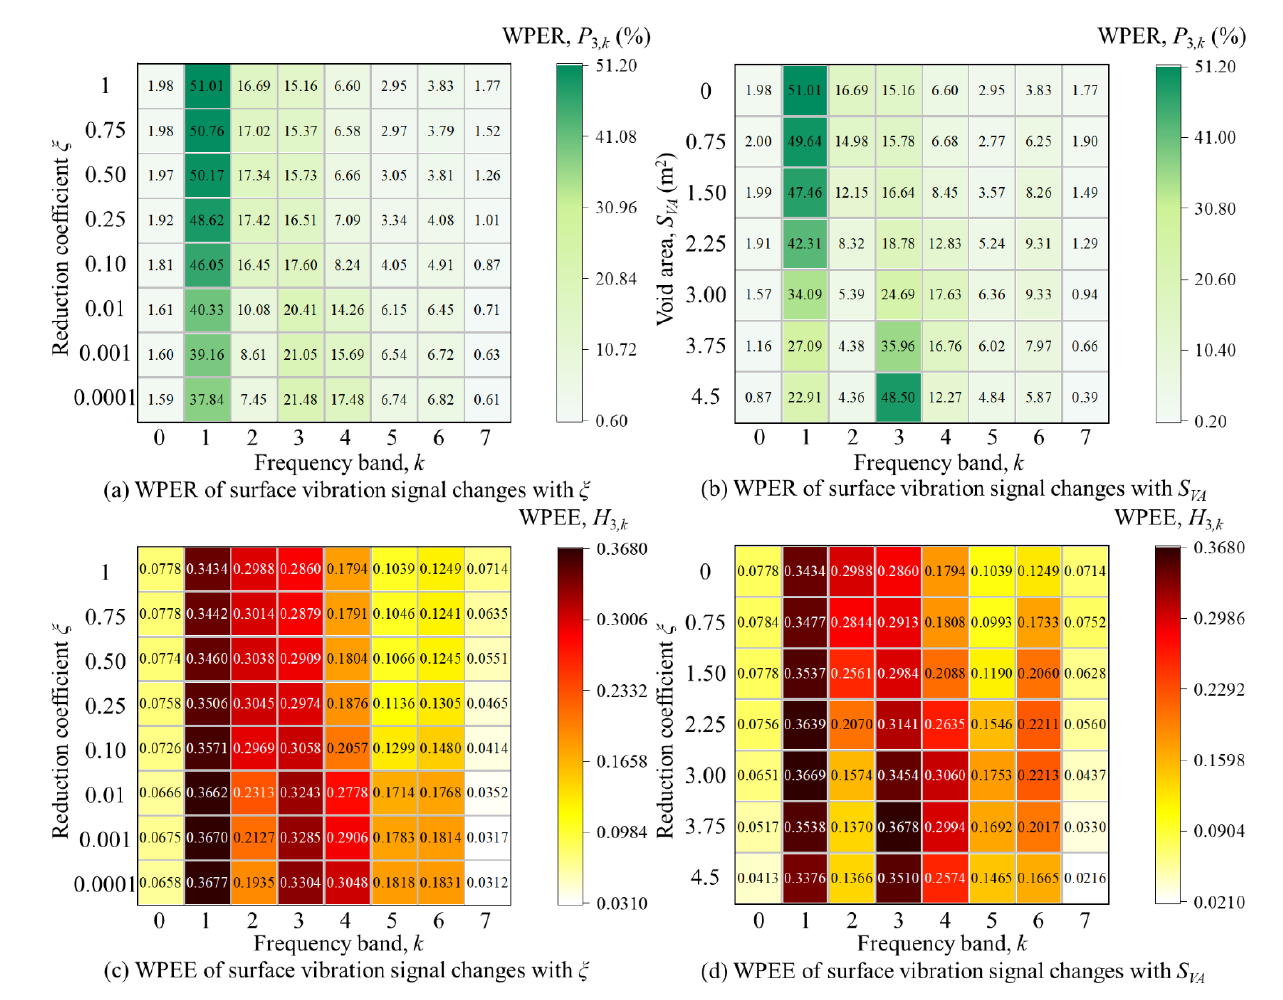
Figure 15. Energy distribution characteristics of vibration signal at monitor point 3.